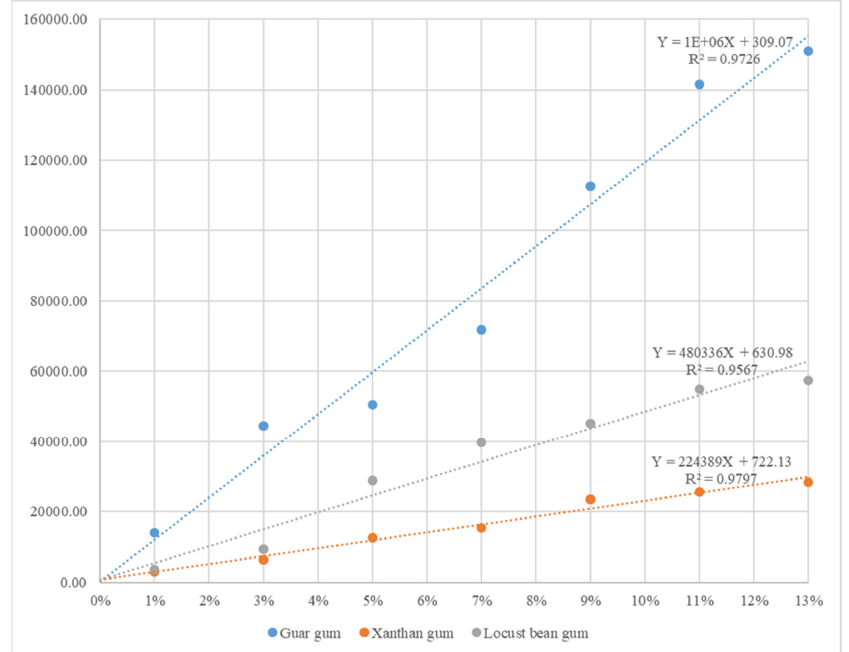
Figure 1. Regression equation for harness according to gelling agent of Kaniwa mousse. Y-scale is the “hardness (N/m 2 )” and X-scale is the “concentration (%) of the gelling agent”. The coefficient of determination (R 2 ) is a number between 0 and 1 that shows how well the statistical model predicts the outcomes, and the higher the coefficient, the better the observations fit.